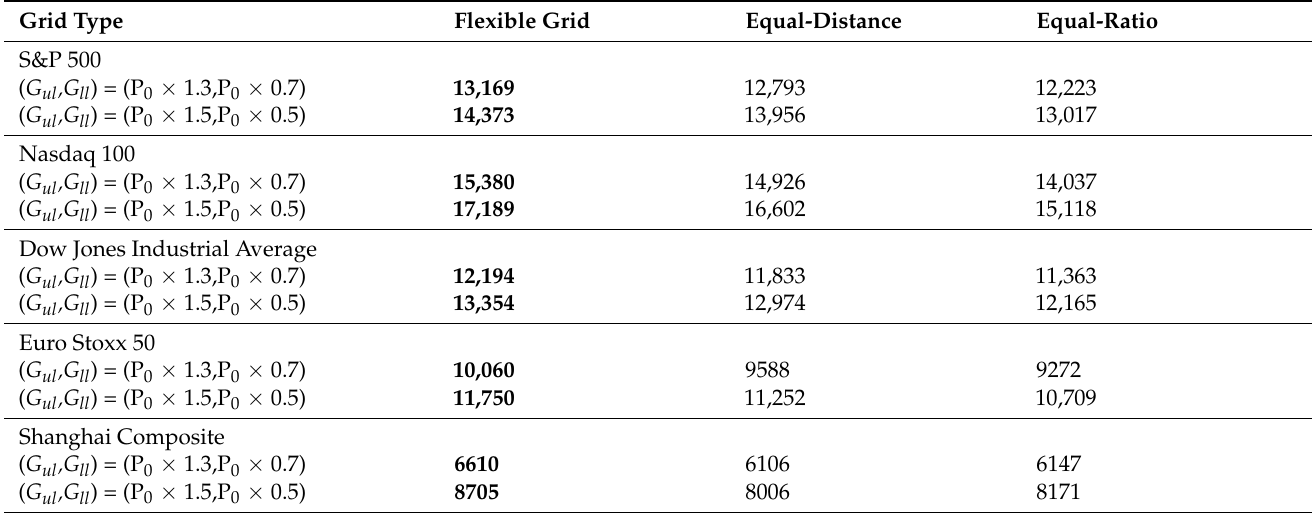
Table 4. Accumulated wealth obtained by flexible grid, equal-distance grid, and equal-ratio grid.